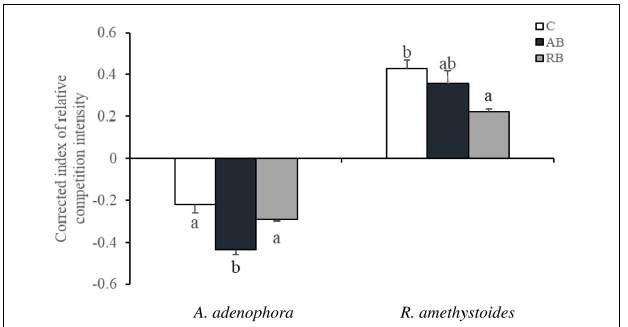
FIGURE 3 | Effect of Bacillus on the corrected index of relative competition intensity (CRCI) of invasive plant A. adenophora and native plant R. amethystoides. Different lowercase letters indicate significant differences among the inoculation treatments at p < 0.05. Error bars represent ± 1SE of the mean ( n =